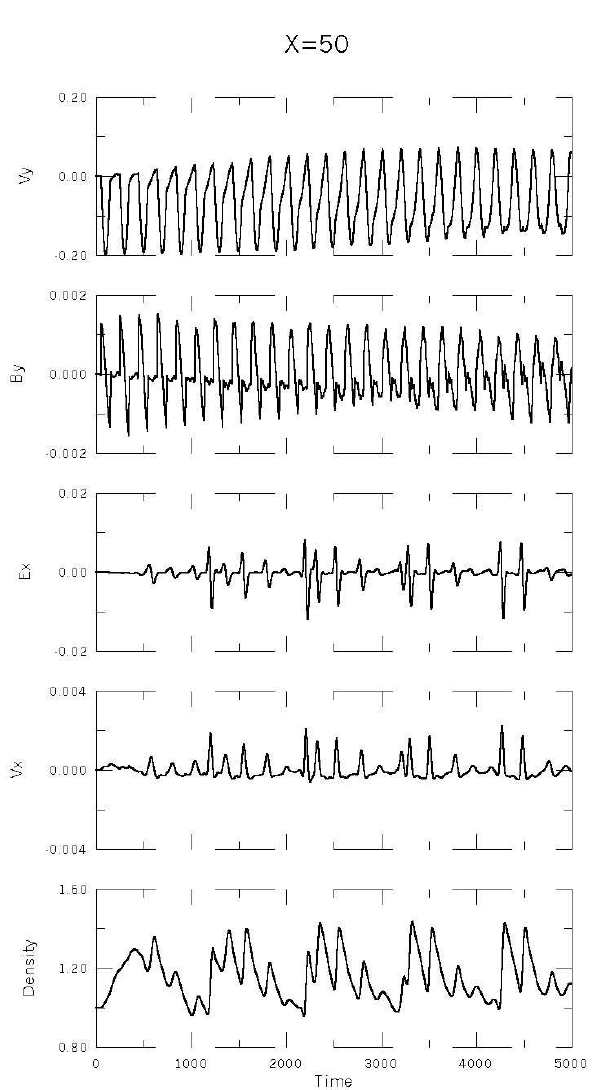
Fig. 4. Same as Fig. 3, but for x=50 (midpoint of the simulation box).